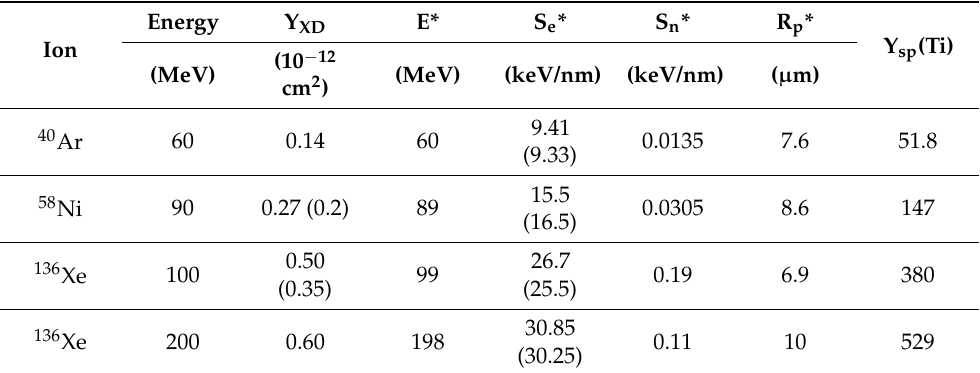
Table 5. XRD data of TiN films. Ion, energy (E in MeV), XRD intensity degradation (Y XD ) for (111) and (200) diffraction on SiO 2 and C-Al 2 O 3 , substrates, Y XD for (220) diffraction on R-Al 2 O 3 in